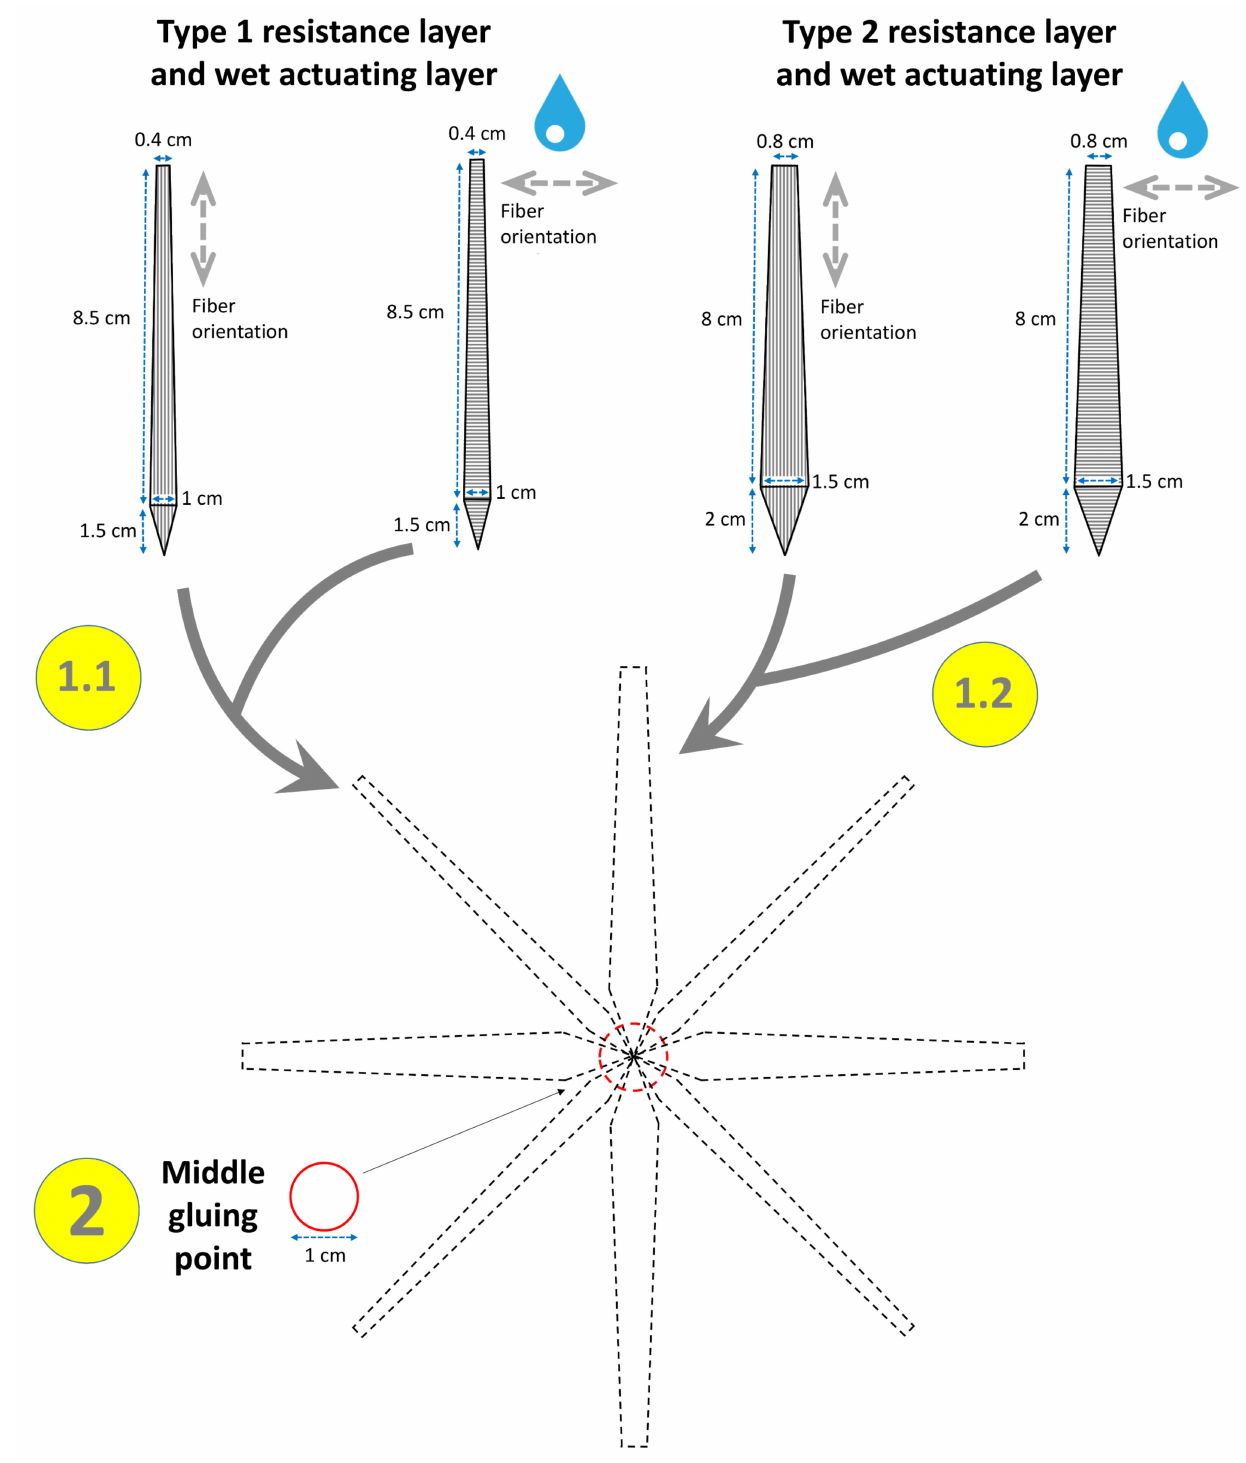
Figure 3. Exemplary construction scheme for the abstraction of the composite structure of the spike-moss S. lepidophylla and its transfer into a paper-based self-actuated compliant system. The various construction steps are numbered (1, 2). Steps 1.1 and 1.2 (construction of “stems” and their attachment by glue to the circular middle point) do not have to be undertaken in any particular order and can be repeated as many times as required (in our case: four each). The fiber orientations of the dry RLs and wet ALs are indicated (gray dashed arrows). Details are provided in the main